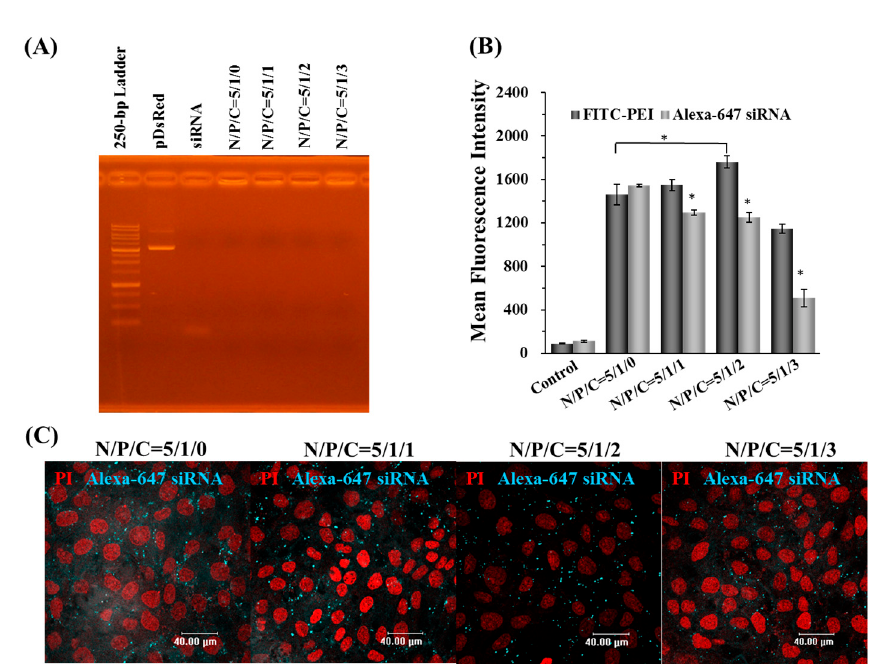
Figure 5. The stability and cellular uptake of PEI/dual nucleic acids/ γ -PGA nanoparticles ( γ -DDNPs). The nanoparticles were prepared by using different amount of PEI, plasmid DNA, siRNA, and γ -PGA. The stability of different N/P/C ration were analyzed under electrophoresis ( A ). Total cellular uptake of γ -DDNPs (FITC- or Alexa Fluor-647 labeled) with varying N/P/C ratio from 5/1/0 to 5/1/3 were analyzed by flow cytometry ( B ). After incubated with γ -DDNPs of different N/P/C ratios associated with varying N/P/C ratio (5/1/0 to 5/1/3), the fluorescence images of cells were photographed with fluorescence microscope ( C ). The control group denotes the group of cells without any treatment. * p < 0.05, significant difference between the test groups and the group with N/P/C ratio of 5/1/0 as analyzed by Student’s t test.